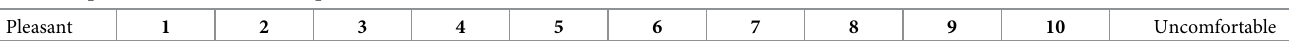
Table 3. Post-procedural remembered